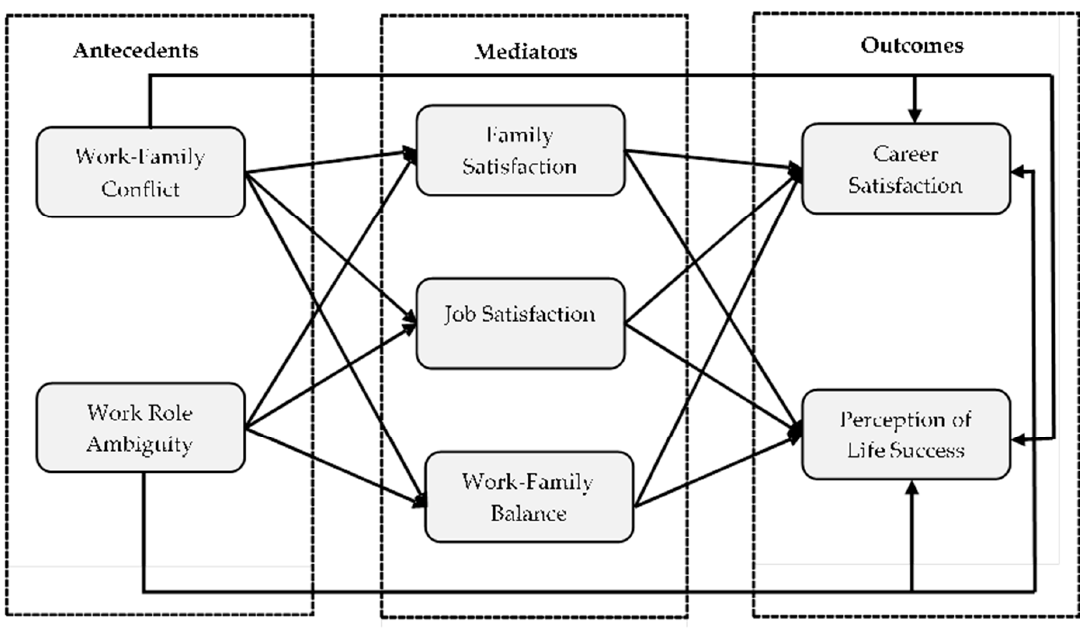
Figure 1. The conceptual model.